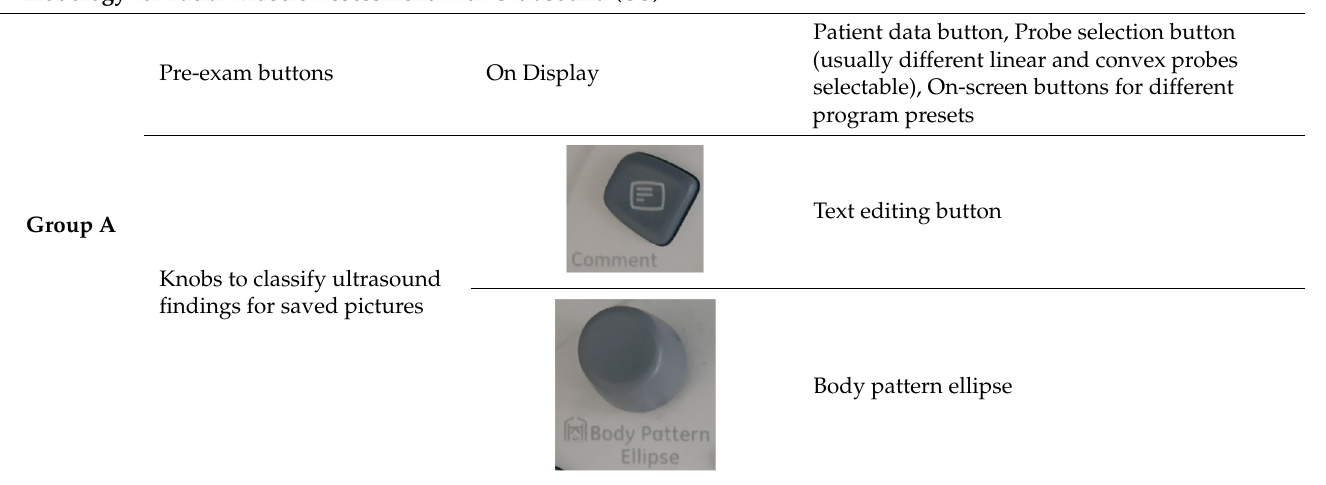
Figure 1. Knobology of a standard ultrasound (US) device. Useful buttons for simplified US usage are marked in red. Time gain controls (TCG) may be all set in the middle position. The depth is varied by the upper and lower lever actions (far right, up). The “Auto Optimize” button harmonizes the image quality. P1 can be programmed to save/store images (in freeze) or cine loops (in a nonfro- zen visualization). Table 1. Functional classification of ultrasound (US) knobology. Group A comprises on-screen options and knobs to store patient data, probe the selection, and classify the ultrasound findings for saved images. Group B includes knobs, switches, and buttons that help to adjust the Contrast, Frequency, Focus, Depth, and other settings. Group C summarizes the functions to quantify distances using a measuring tool.